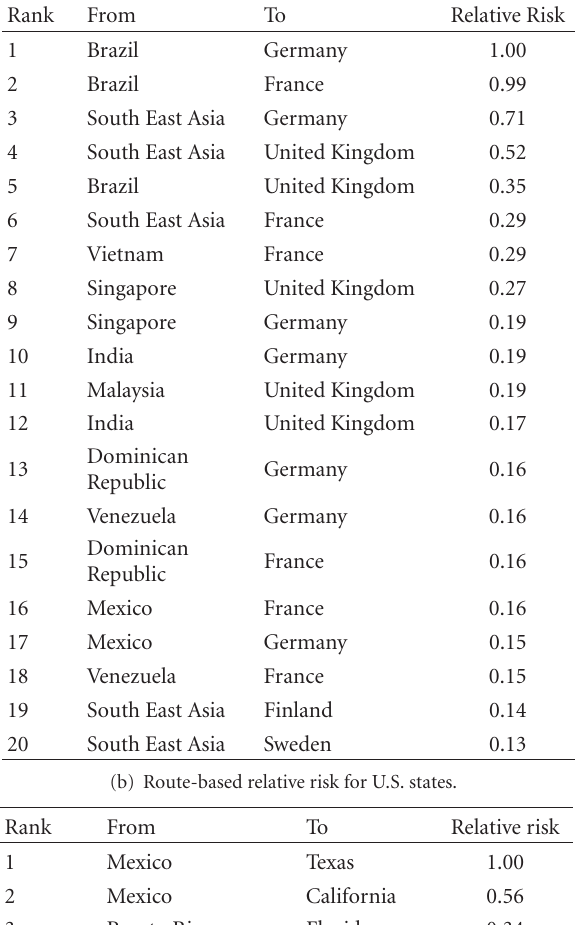
Table 3: Relative risk of spreading travel acquired dengue infection via international travel routes from endemic countries into (a) Europe and (b)